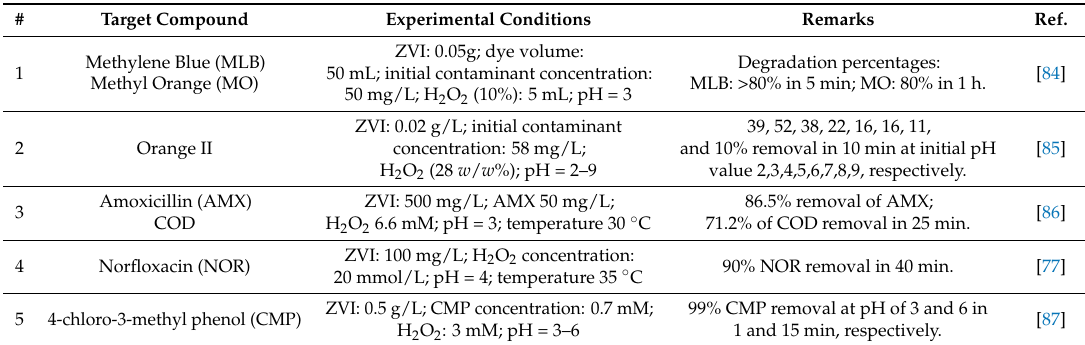
Table 1. Overview of works done in the area of heterogeneous Fenton using ZVI as